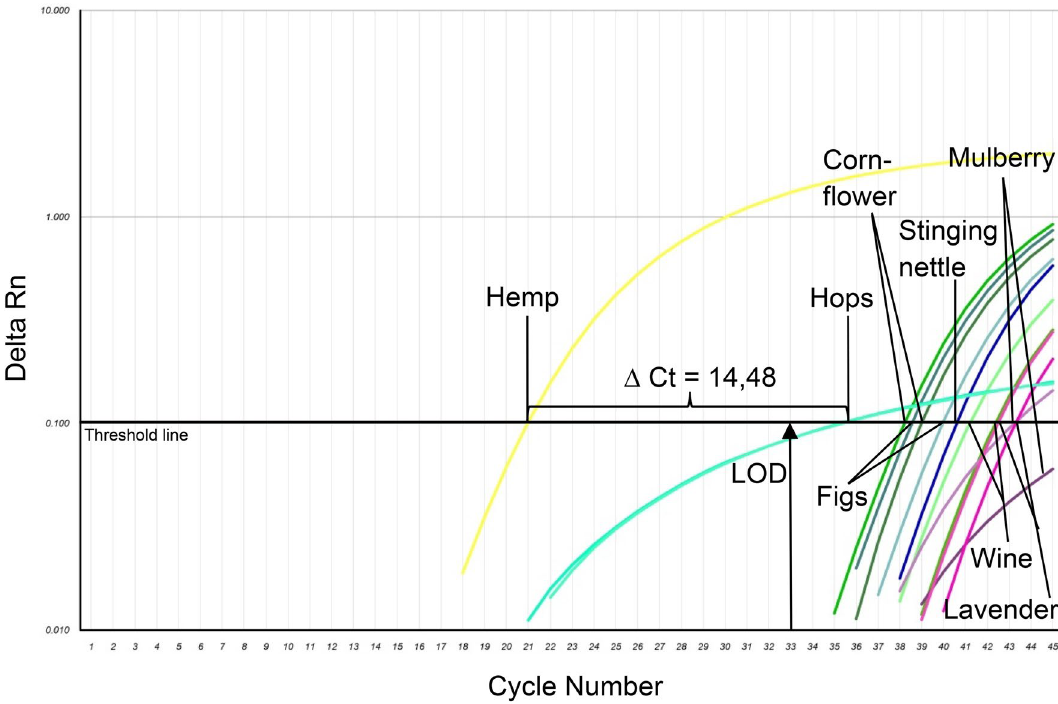
Figure 3. Results of cross-reactivity tests obtained with 5 ng/µl DNA per tube. Cross-reacting species: mulberry, stinging nettle, lavender, cornflower, wine, figs and hops. The cross-reactivity is negligible, because the ∆ Ct values are > 14 and the Ct values are beyond the determined limit of detection.